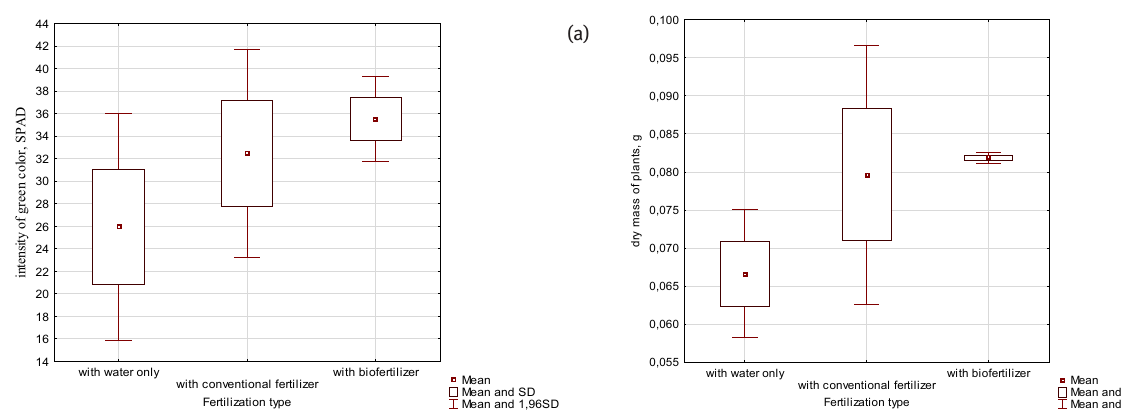
Figure 3: The major growth parameters of plants in germination test; a – intensity of green color, b –the dry mass of plants